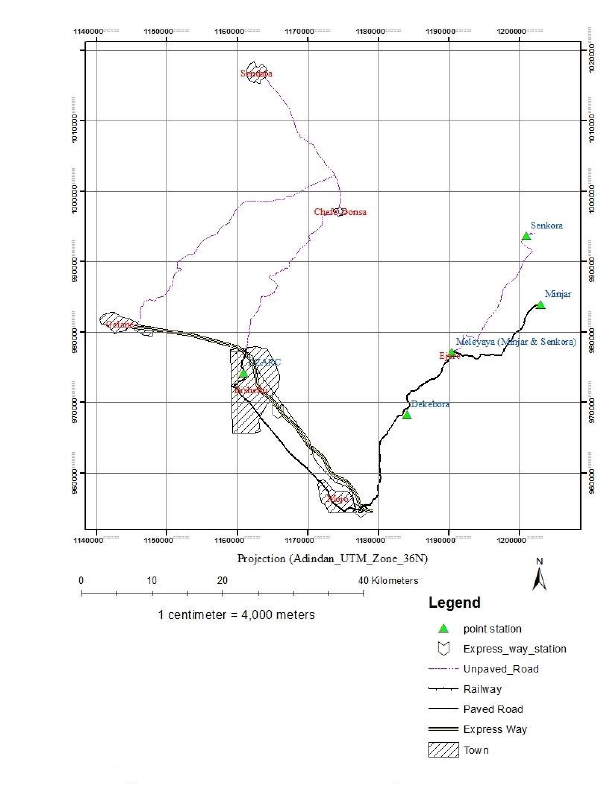
Figure 1. Travel routes for direct farm assessment.